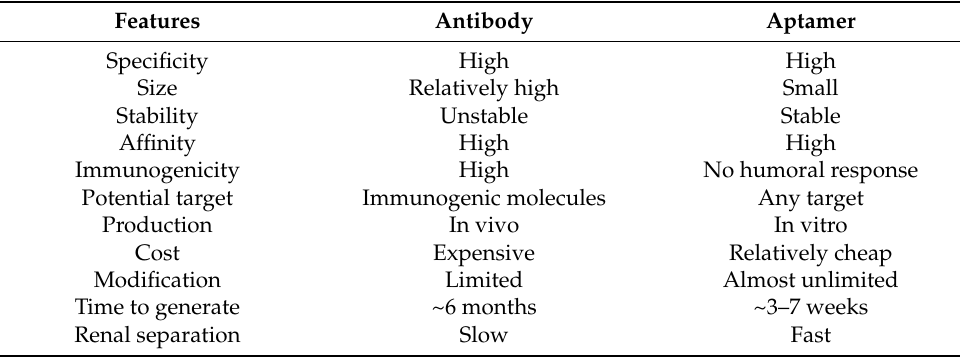
Table 1. Comparison of the properties of antibodies and aptamers [128,129]. Features Antibody